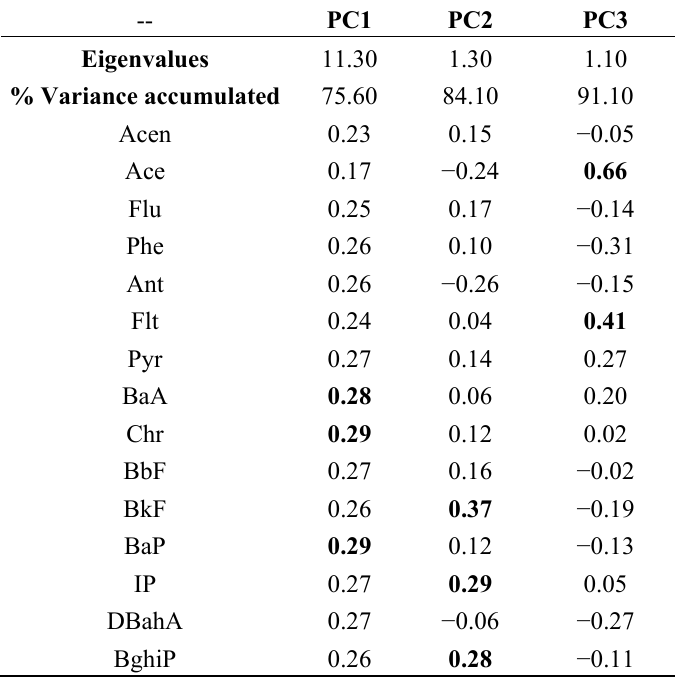
Table 3. Principal Component Analysis for